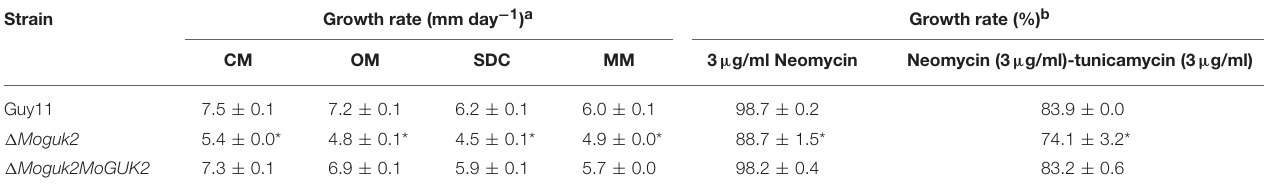
a Mean and standard deviation were calculated with results from three replicates. Asterisk represents significant differences at P < 0.01. b The growth rate was determined 7 days after incubation at 28 ◦ C by plotting the percentage of colonies in the presence of various drugs against regular CM.